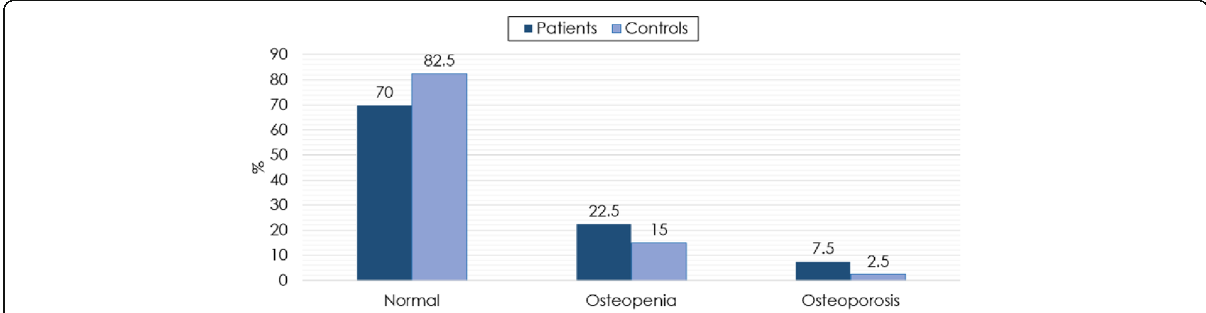
Fig. 1 The frequency of osteopenia and osteoporosis in RA patients and